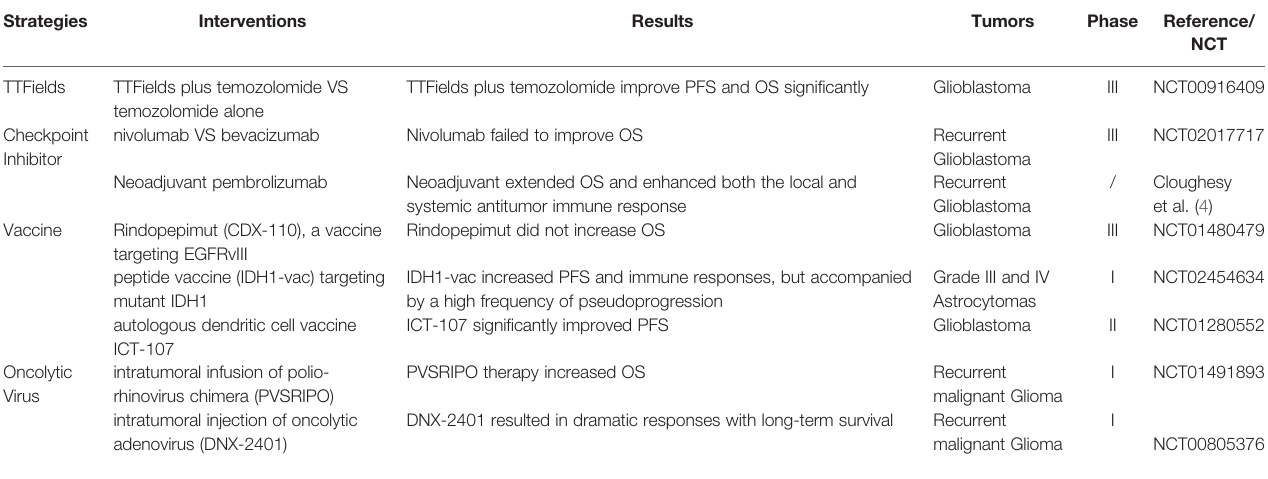
TABLE 1 | Applications of novel strategies in